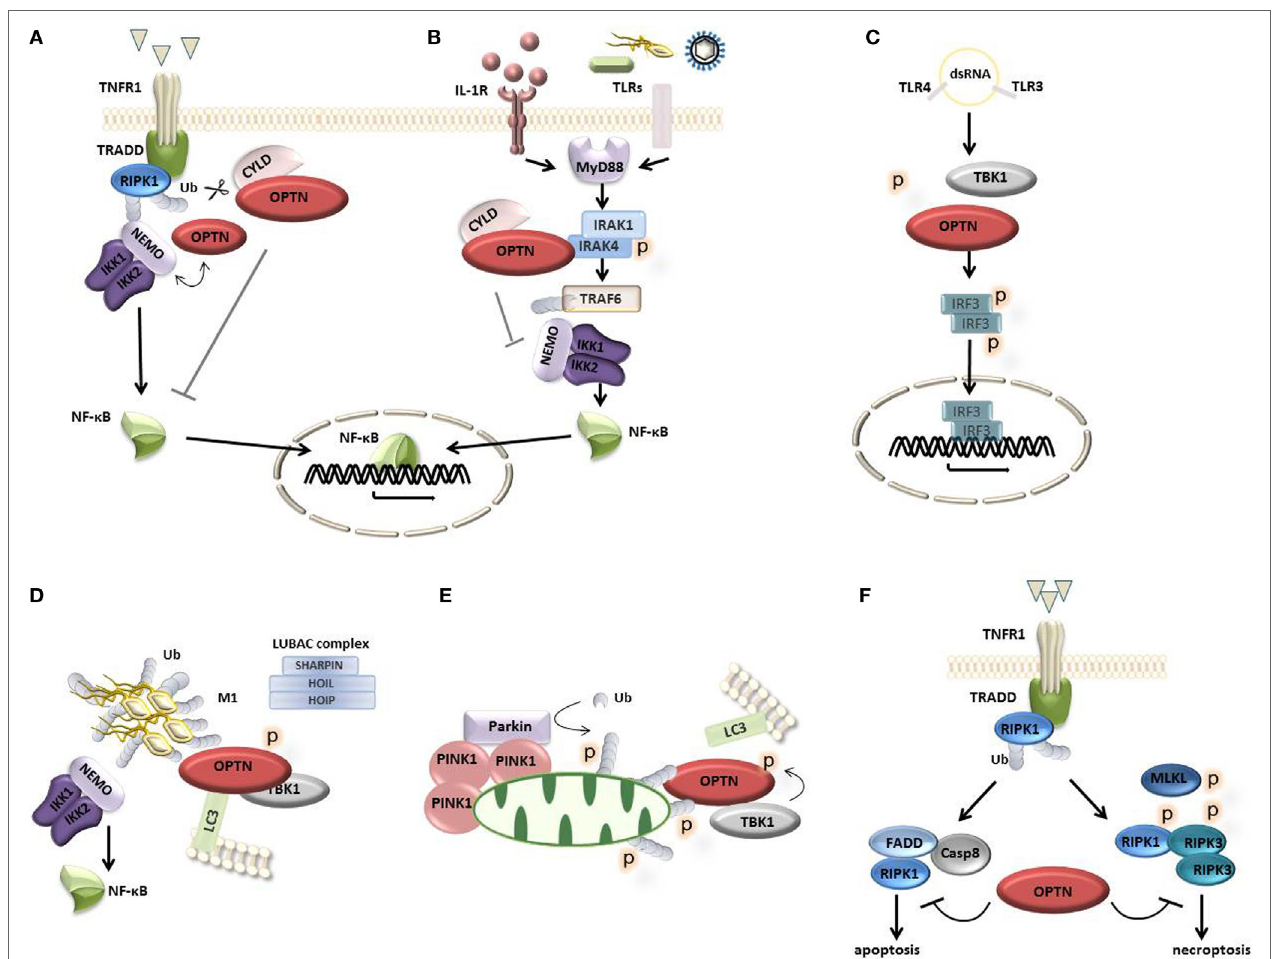
FiGURe 2 | Optineurin (OPTN) in cellular signaling. (A) Upon activation of tumor necrosis factor (TNF) receptor 1, OPTN is recruited to the receptor complex where it competes with nuclear factor- κ B (NF- κ B) essential modulator (NEMO) for ubiquitinated RIPK1. OPTN can also recruit the deubiquitinating enzyme cylindromatosis (CYLD), which cleaves off ubiquitin chains from proteins such as NEMO and RIPK1, blocking downstream NF- κ B signaling. (B) Upon activation of IL-1 and TLR receptors with their respective ligands, the adaptor protein MyD88 is recruited to the receptor complex where it engages the kinase interleukin-1 (IL-1) receptor- associated kinase 1 (IRAK-1) and the E3 ligase TRAF6, inducing TRAF6 auto-ubiquitination and downstream NF- κ B signaling. OPTN can bind IRAK-1 through its ubiquitin-binding domain preventing TRAF6 ubiquitination and suppressing downstream NF- κ B signaling. This process may involve the recruitment of CYLD. (C) Bacterial LPS and viral double-stranded RNA (dsRNA) induce the activation of TANK-binding kinase 1 (TBK1), which binds and phosphorylates OPTN, leading to the phosphorylation, dimerization, and nuclear translocation of IFN regulatory factor 3 (IRF3), mediating the transcription of interferon type I response genes. (D) OPTN acts as an autophagy receptor that associates with ubiquitin-coated cytosolic bacteria and recruits TBK1 to phosphorylate OPTN, enhancing its LC3 binding affinity, directing autophagosomal degradation. The LUBAC complex (consisting of Sharpin, HOIL-1, and HOIP) mediates the linear ubiquitination at the bacterial surface inducing the recruitment of NEMO and OPTN to activate NF- κ B signaling and autophagy. (e) Damaged mitochondria are removed through mitophagy, a process involving the kinase PINK1 and the E3 ubiquitin ligase Parkin, which conjugates ubiquitin to mitochondrial outer membrane proteins, recruiting OPTN. This process involves TBK1-dependent OPTN phosphorylation promoting the autophagosomal degradation of mitochondria. (F) OPTN can bind caspase 8, limiting complex II formation and apoptosis. Alternatively, OPTN can regulate the turnover of ubiquitinated RIPK1 protecting from